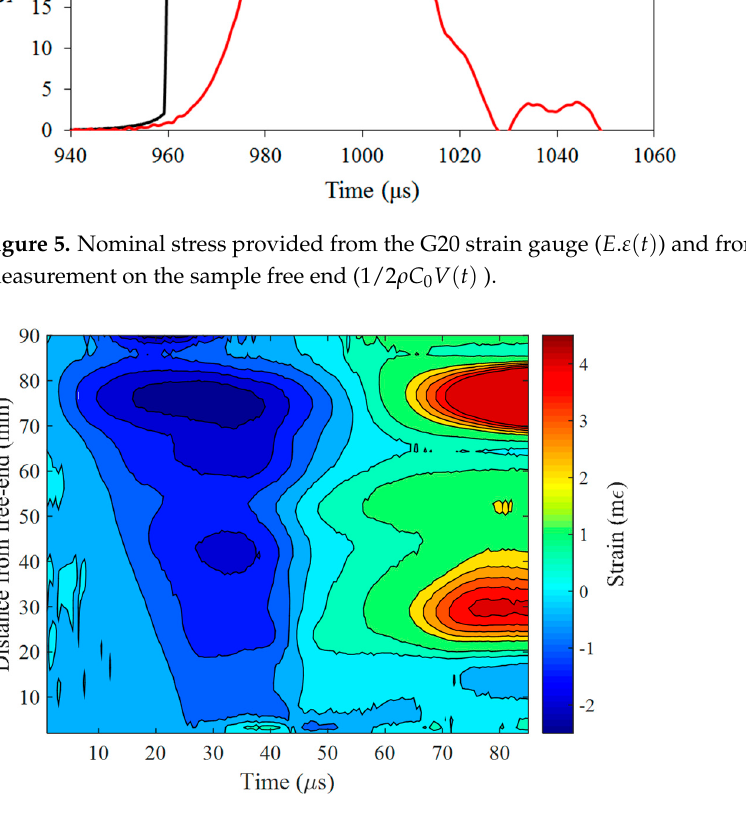
Figure 6. Space-time map of average axial strain from test #2. The isocontours have a step of 0.5 m ε .